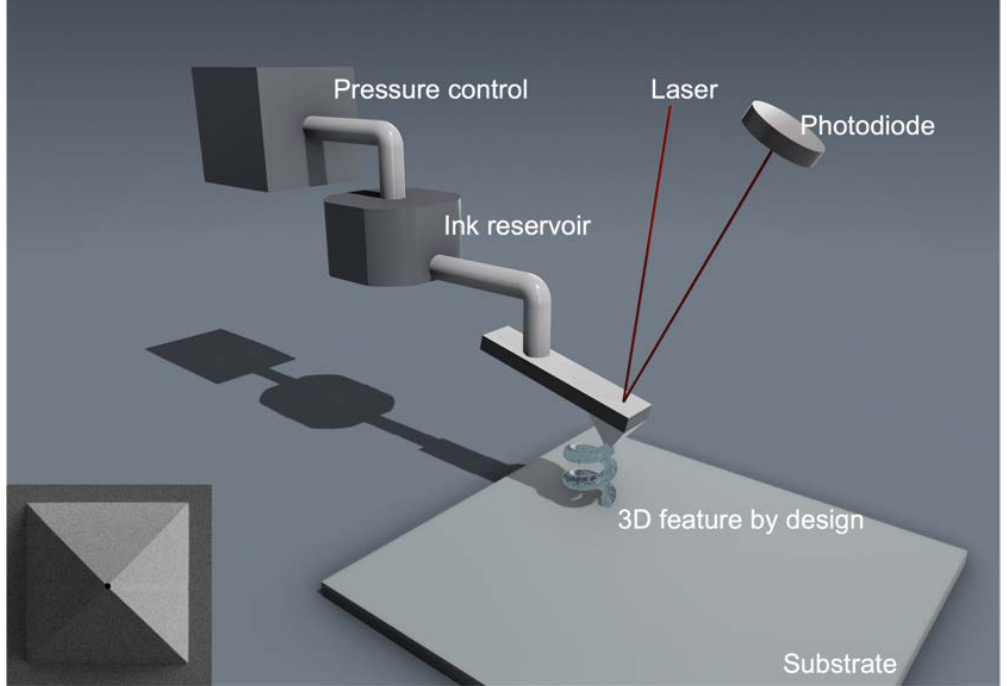
Figure 1. Schematic (not to scale) diagram of an AFM with microfluidic delivery probe. (inset) SEM image of the nanopipette apex with a 300 nm aperture.